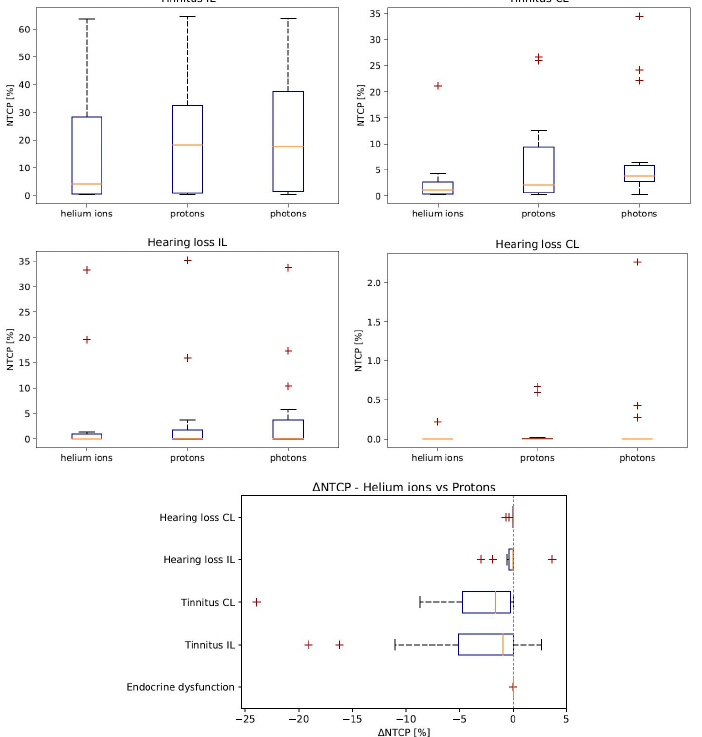
Figure 4. NTCP distribution for endpoints tinnitus and hearing loss (n = 15). The orange line shows the median. The blue box contains 50% of the calculated values. Helium ions lead to the lowest NTCP. Last boxplot shows Δ NTCP comparing helium ions to protons (NTCPHe-NTCPH+). Helium ions lead to NTCP reduction.